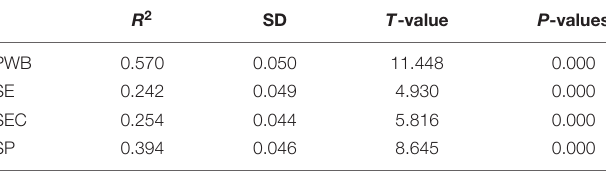
TABLE 6 | Collinearity statistics (VIF). TABLE 7 | Coefficient of determination ( R 2